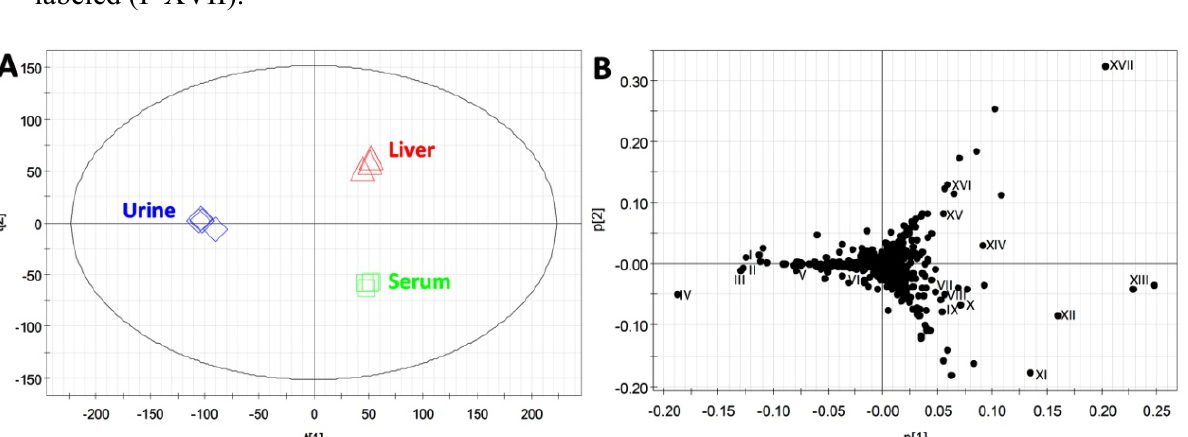
Figure 4. LC-MS-based metabolomic analysis of HQ-derivatized serum, urine and liver extract samples from wild-type mice. ( A ) The scores plot of a principal components analysis (PCA) model on three groups of biological samples (n = 4). The t [1] and t [2] values represent the scores of each sample in the principal components 1 and 2, respectively. ( B ) The loadings plot of ions detected by LC-MS analysis. The p [1] and p [2] values represent the contributing weights of each ion to the principal components 1 and 2 of the PCA model, respectively. Major contributing ions in each sample group are labeled